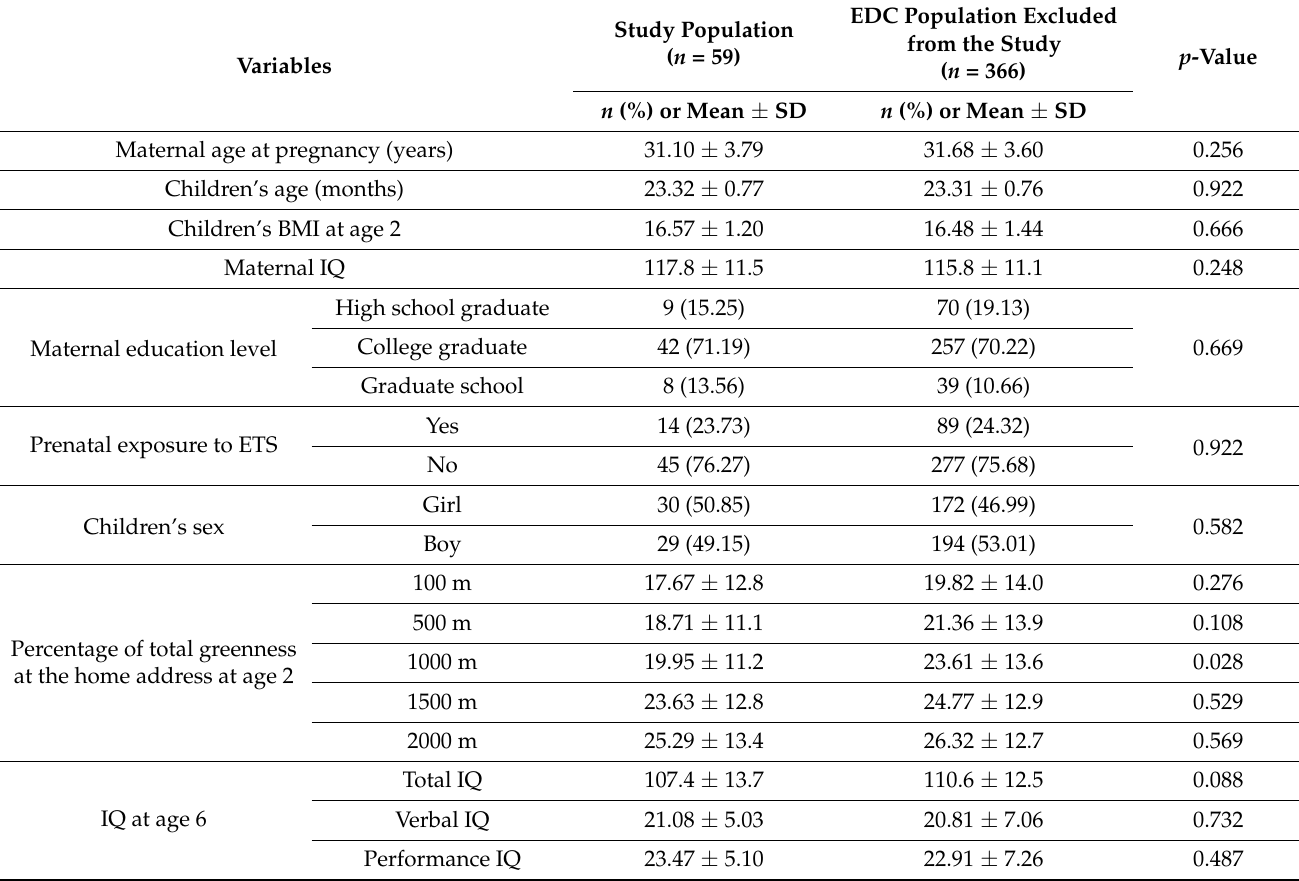
Table 1. Characteristics of participants at age 2 in sub-study compared to total EDC population.